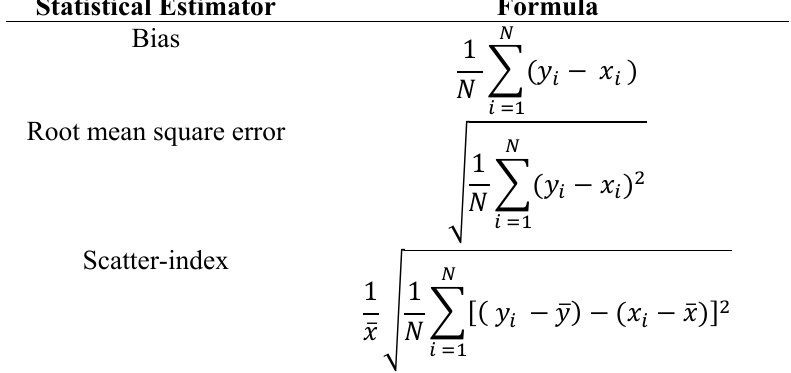
Table 2. Equations used for calculating error statistics for evaluation of algorithms. Statistical Estimator Formula